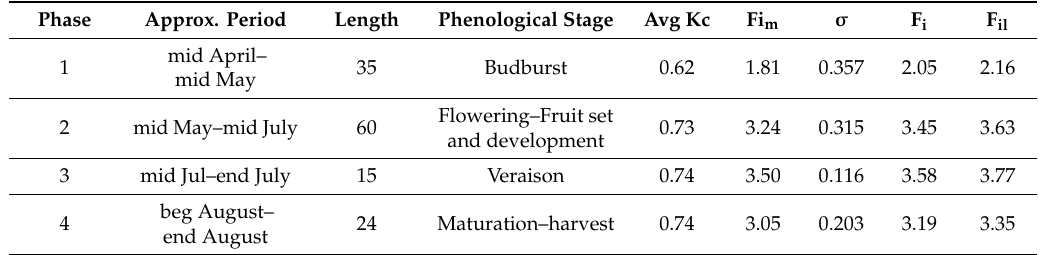
Table 2. Characterization of the four phases in which the vineyard crop development was divided; for each phase, the approximate period, the reference phenological stage, the average crop coe ffi cient (Kc) and the irrigation requirements (F i and F il ) calculated according to Equations (3) and (4) are reported.